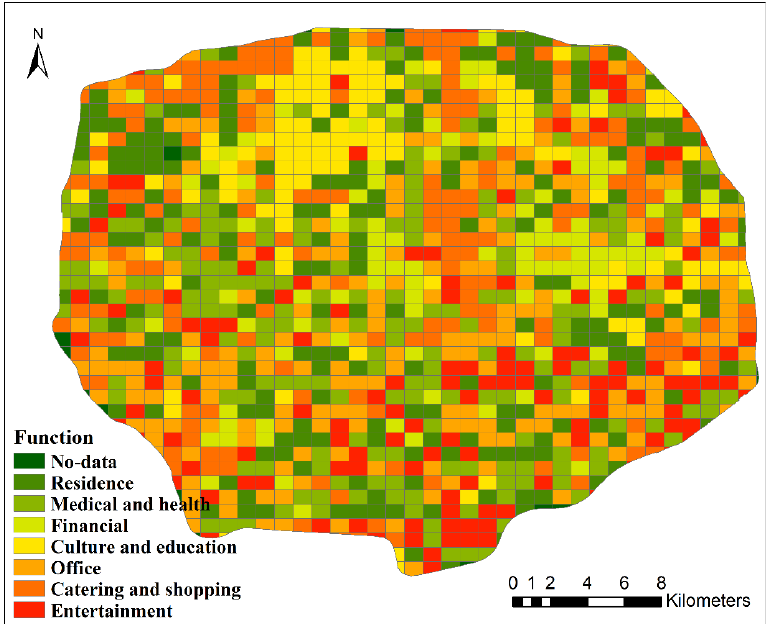
Figure 8. Distributions of the types of urban functions. Table 7. Proportions of functional types in hotspot areas with different spatiotemporal units.